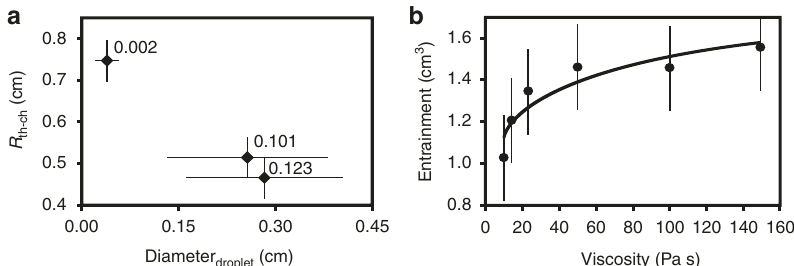
Fig. 6 Entrainment by metal droplets. a The average radius of the chemical plume versus the average diameter of the emulsi fi ed droplets holding all other fl uid properties constant. The Bond number values of each experiment are given at each point (Experiments 20 – 22). b Entrainment around a single solid metal sphere measured as a function of μ 1 determined at a constant depth (5 cm) from the interface. A best fi t curve (black line) indicates